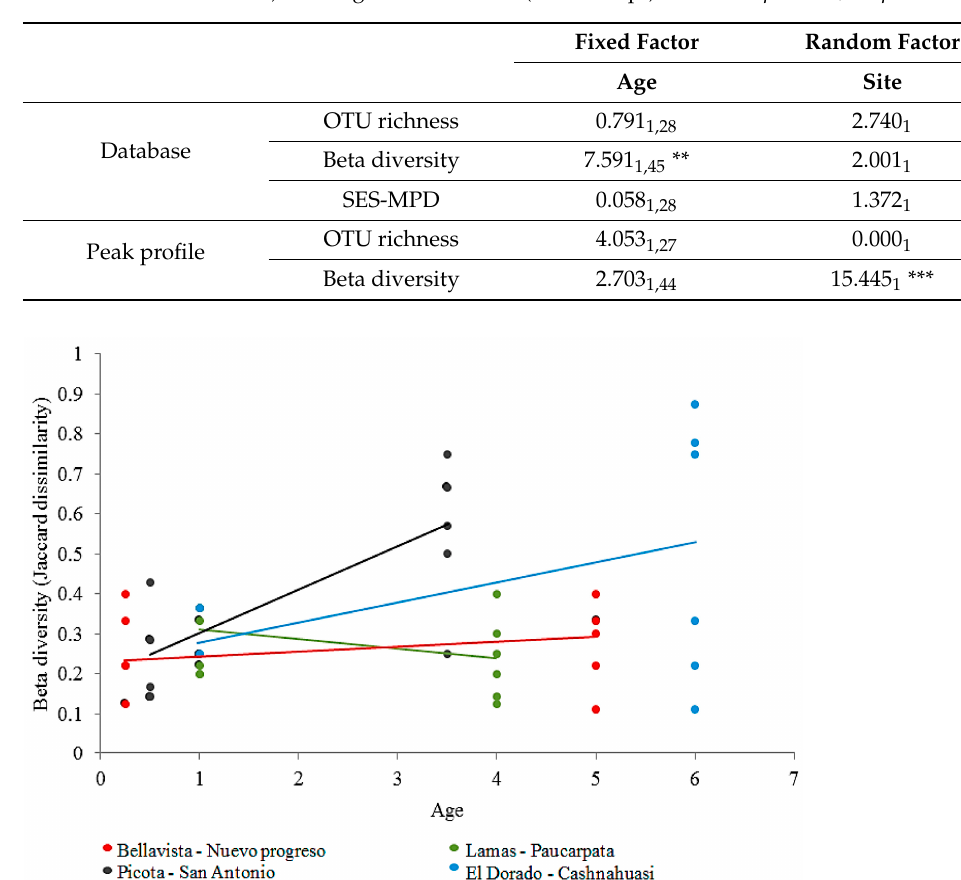
Table 1. Results of linear mixed models testing the effect of age on arbuscular mycorrhizal diversity metrics for both TRFLP database and peak profile approaches. F values (Likelihood Ratio Test, LRT, in case of random factors) and degrees of freedom (as subscript) shown. ** p < 0.01; *** p < 0.001.